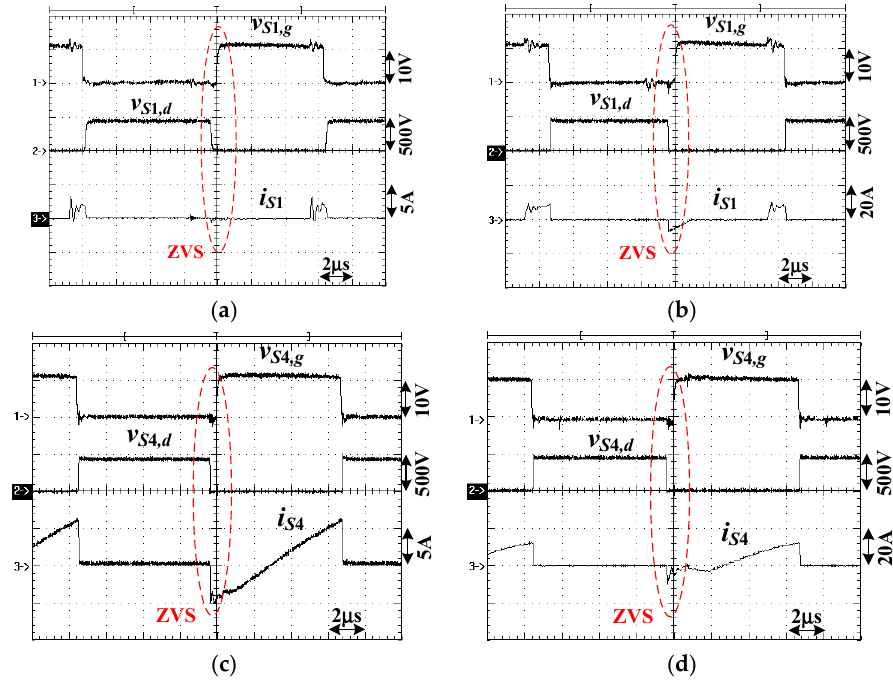
Figure 13. Measured results of S 1 and S 4 at V in = 450 V input ( a ) S 1 waveforms at 160 W (20% load) ( b ) Scheme 1 . waveforms at 800 W (full load) ( c ) S 4 waveforms at 160 W (20% load) ( d ) S 4 waveforms at 800 W (full load).